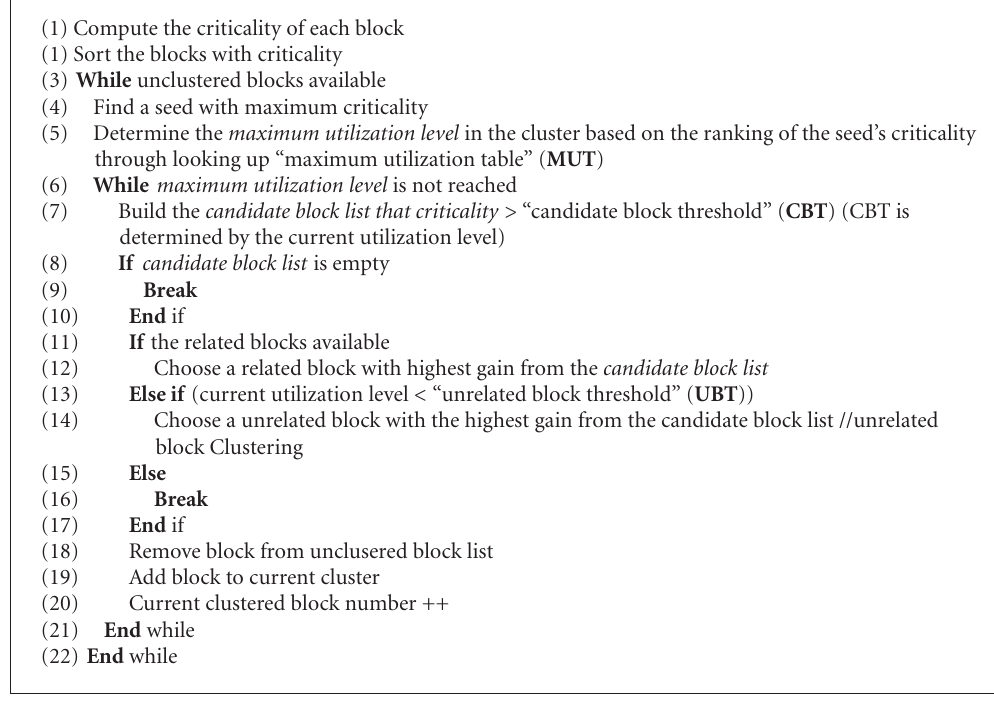
Algorithm 1: The pseudocode for T-NDPack.